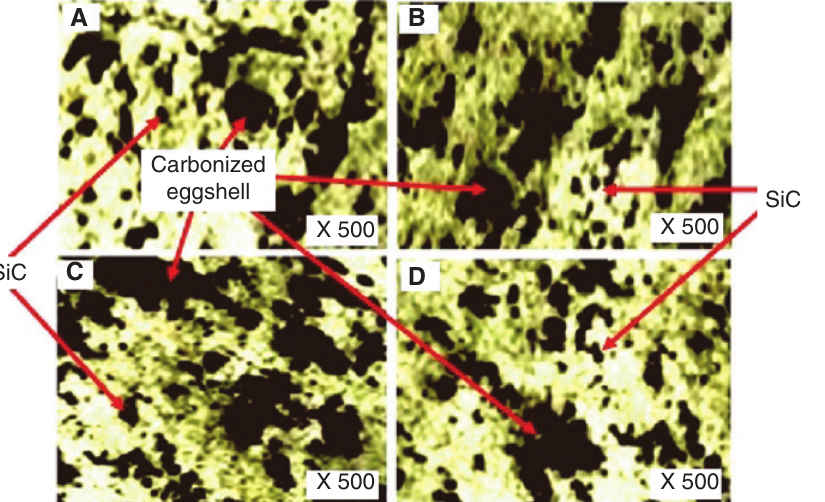
Figure 8: Microstructure of AA2014 reinforced ( × 500) with (A) 2.5% SiC + 2.5% eggshell, (B) 2.5% SiC + 7.5% eggshell, (C) 2.5% SiC + 12.5% eggshell, and (D) 12.5% SiC + 2.5% eggshell.